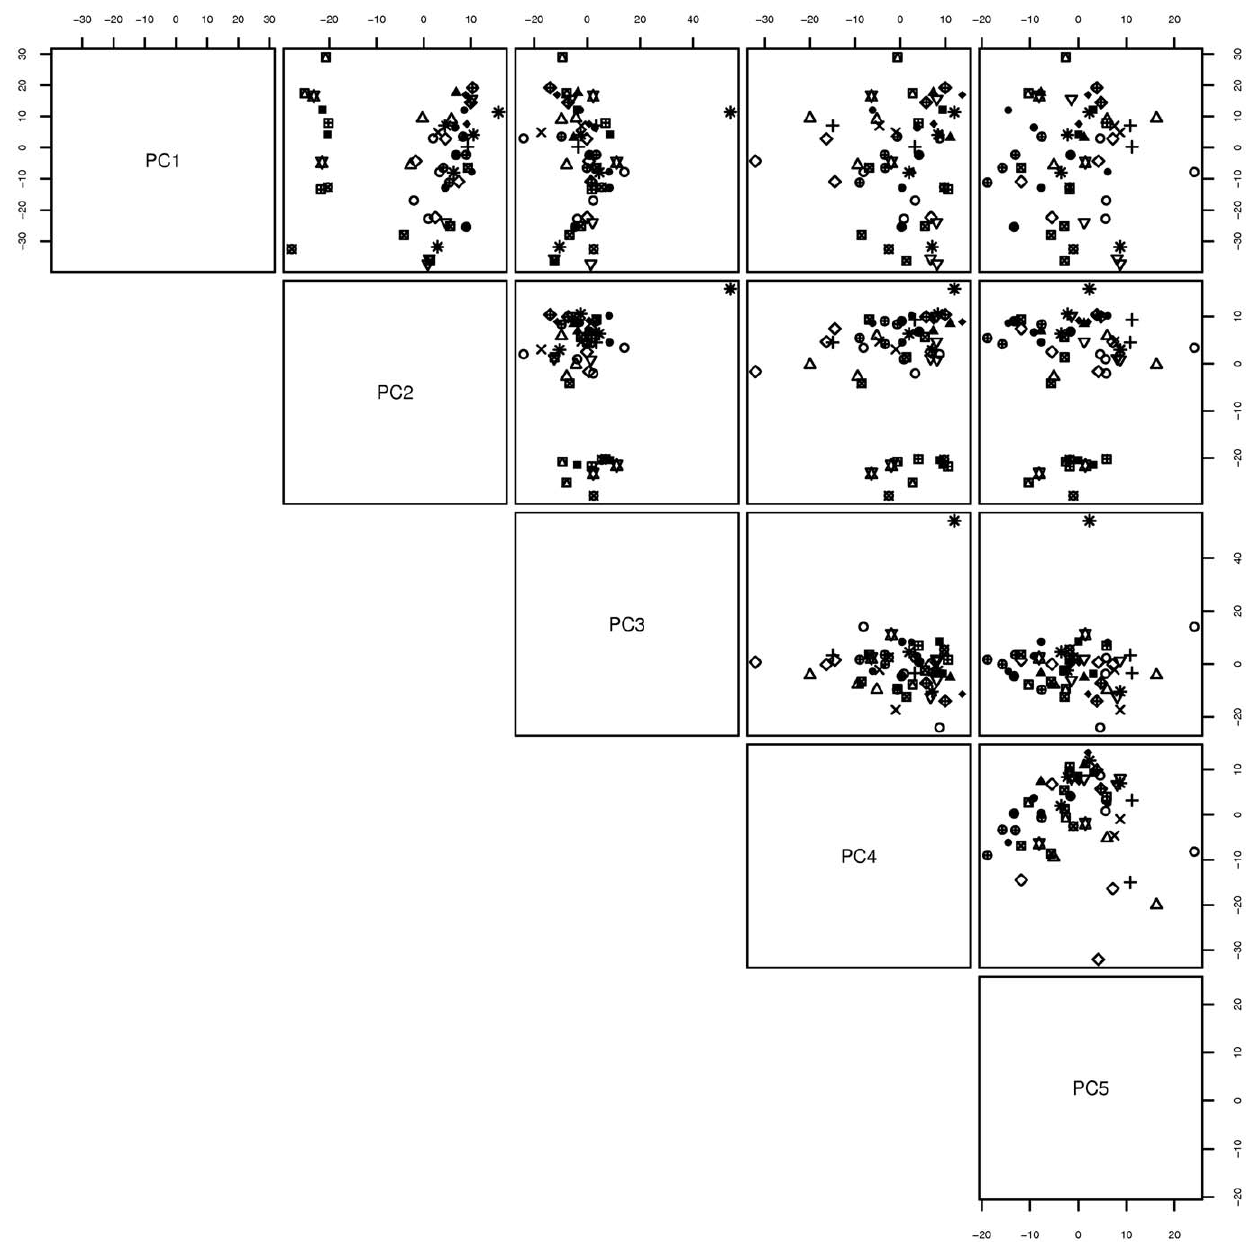
Figure 3. Results of Principal Component Analysis rendered according to pair identification number. This figure utilizes the same bivariate projection setup as Figure 2, but points are symbol coded according to the unique identifier used when matching patients into pairs. For patients with MA who contributed two samples (one at the baseline and one at the microalbuminuric state) there are more than 2 points with the same